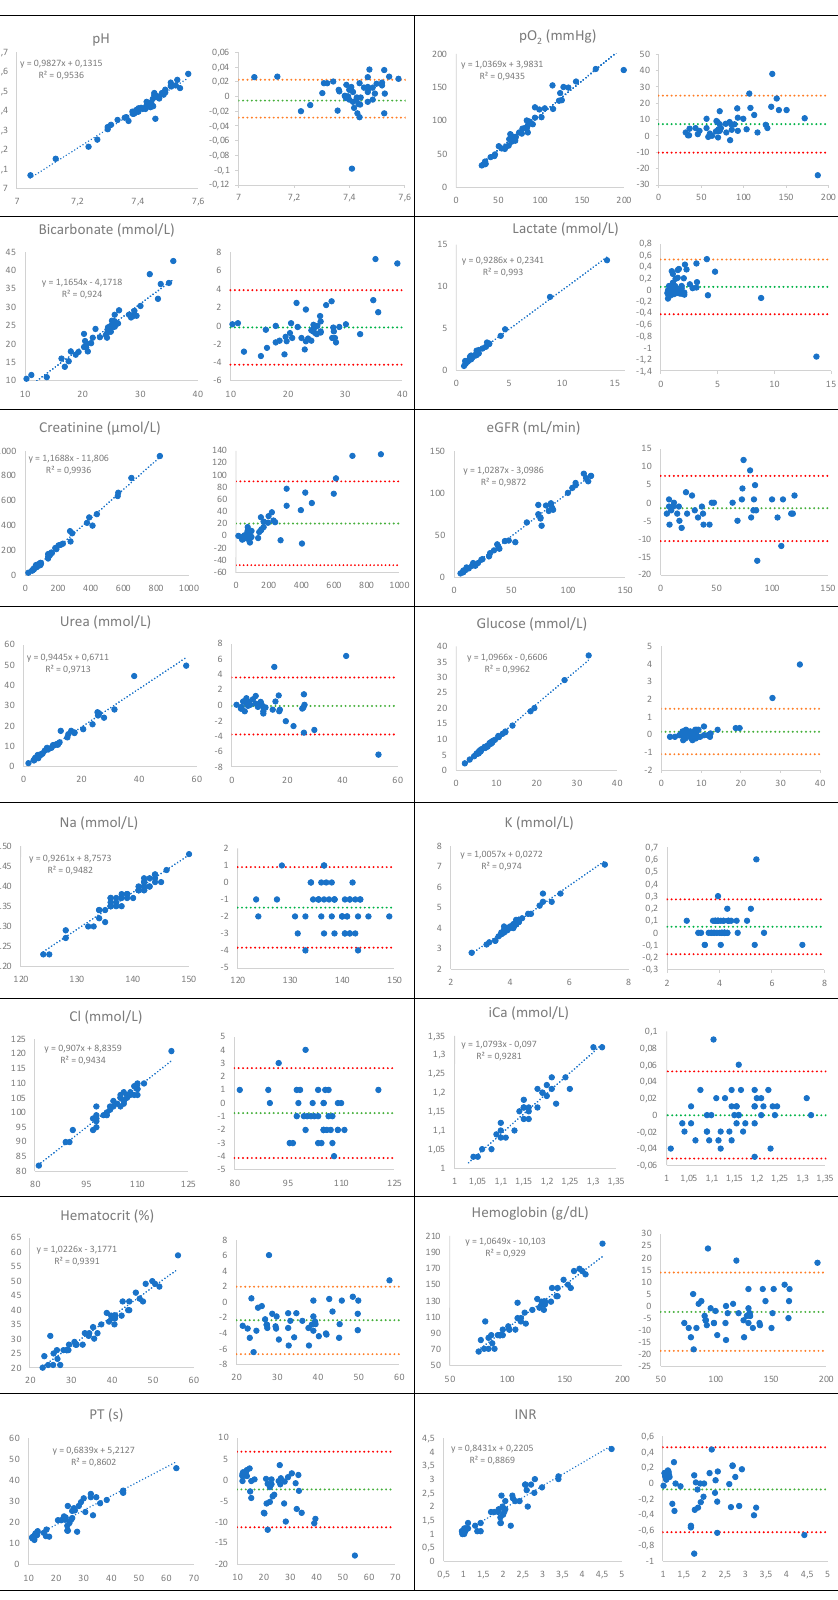
Figure 1. Passing–Bablok regressions of pH, partial pressure of oxygen (Po2), bicarbonate, lactate, glucose, sodium (Na), potassium (K), chloride (Cl) and ionized calcium (iCa), hematocrit and